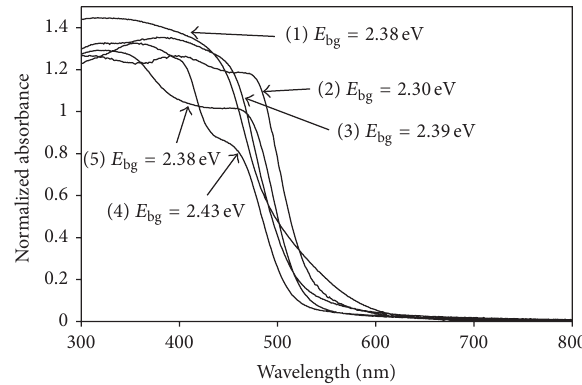
Figure 6: UV-Vis diffuse reflectance spectra (DRS) of BiVO 4 samples prepared via various synthesis methods, (1) BiVO 4 (Co- pre-350-24), (2) BiVO 4 (Comb-500-3), (3) BiVO 4 (Calc-450-5), (4) BiVO 4 (H-140-8), and (5) BiVO 4 (C+H-200-24).